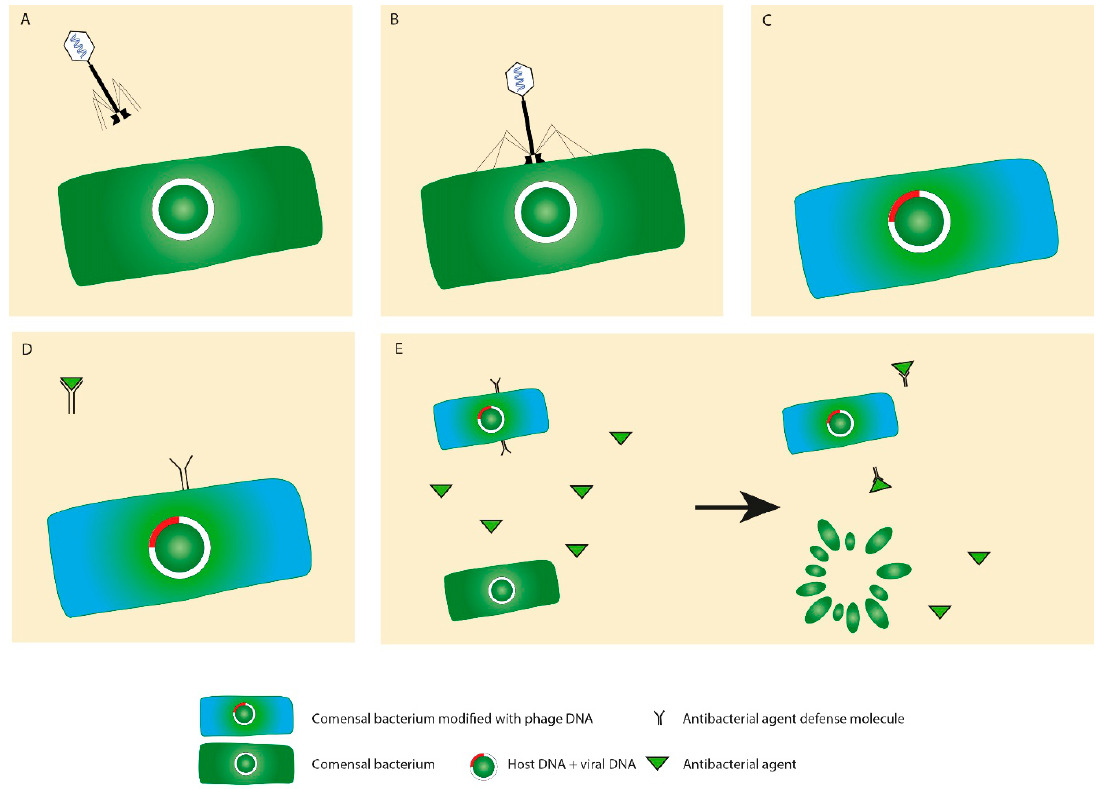
Figure 5. Horizontal gene transfer. In the process of viral infection ( A , B ), bacteria may be equipped with additional genes ( C ), such as genes coding for antibiotic resistance ( D ) or increased pathogenicity that may increase the fitness of the transformed bacterium in contrast to a bacterium that does not have this advantage and, thus, is destroyed ( E ).